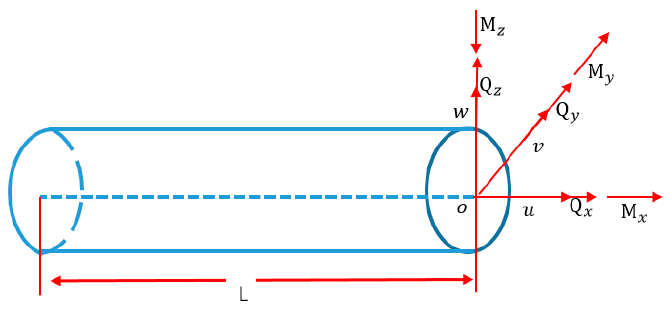
Figure 3. Beam section forces and moments.